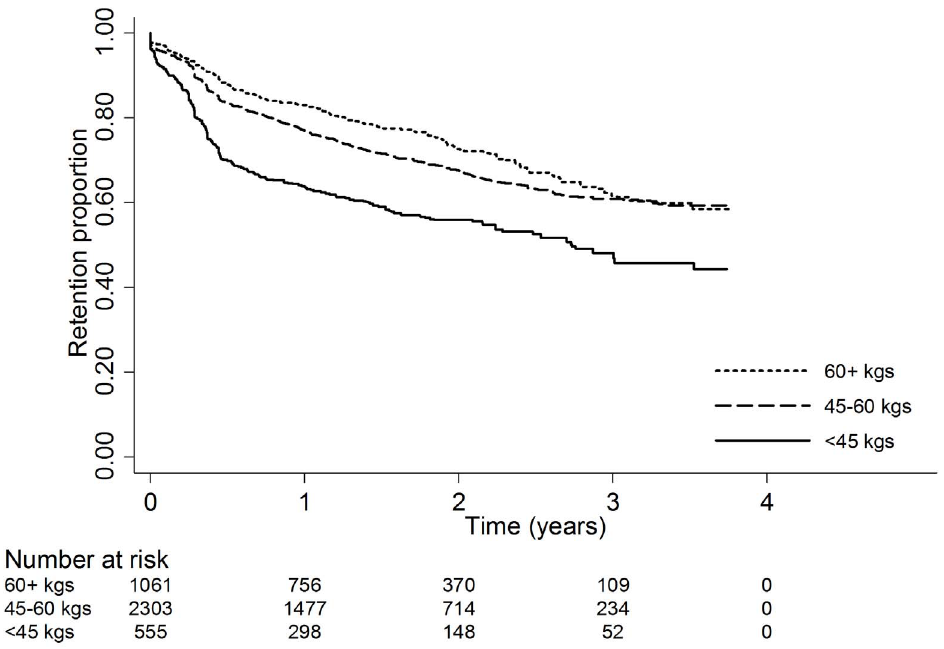
Figure 1. Retention stratified by weight at baseline.